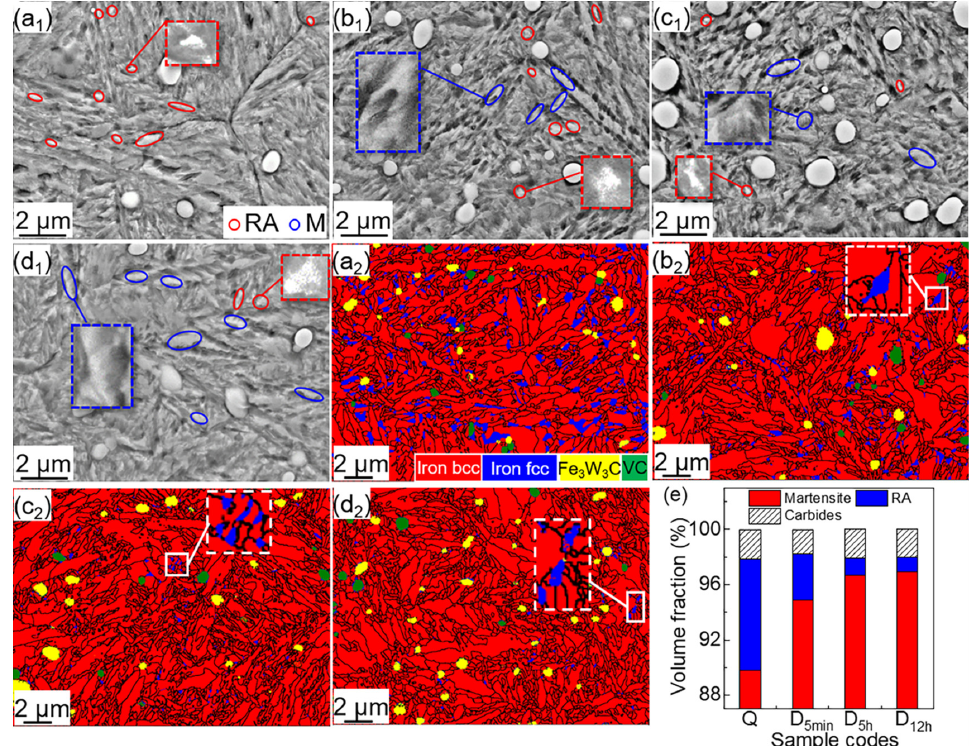
Figure 5. SEM micrographs and phase distribution maps of ( a 1 , a 2 ) Q, ( b 1 , b 2 ) D 5min , ( c 1 , c 2 ) D 5h , and ( d 1 , d 2 ) D 12h , and ( e ) the volume percentage of the phases.